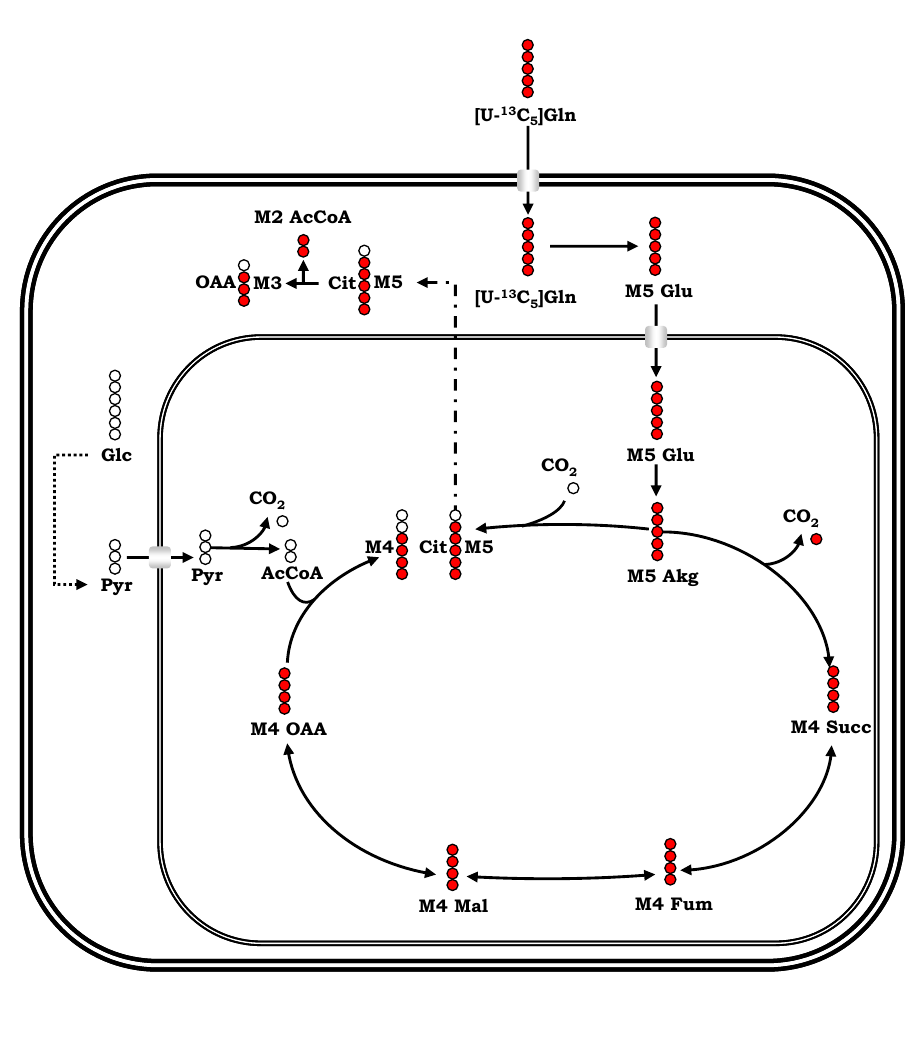
Figure A1. The map illustrates the fate of [U– 13 C (white, respectively) circles denote labeled (non labeled, respectively) carbon atoms in each metabolite. See text for